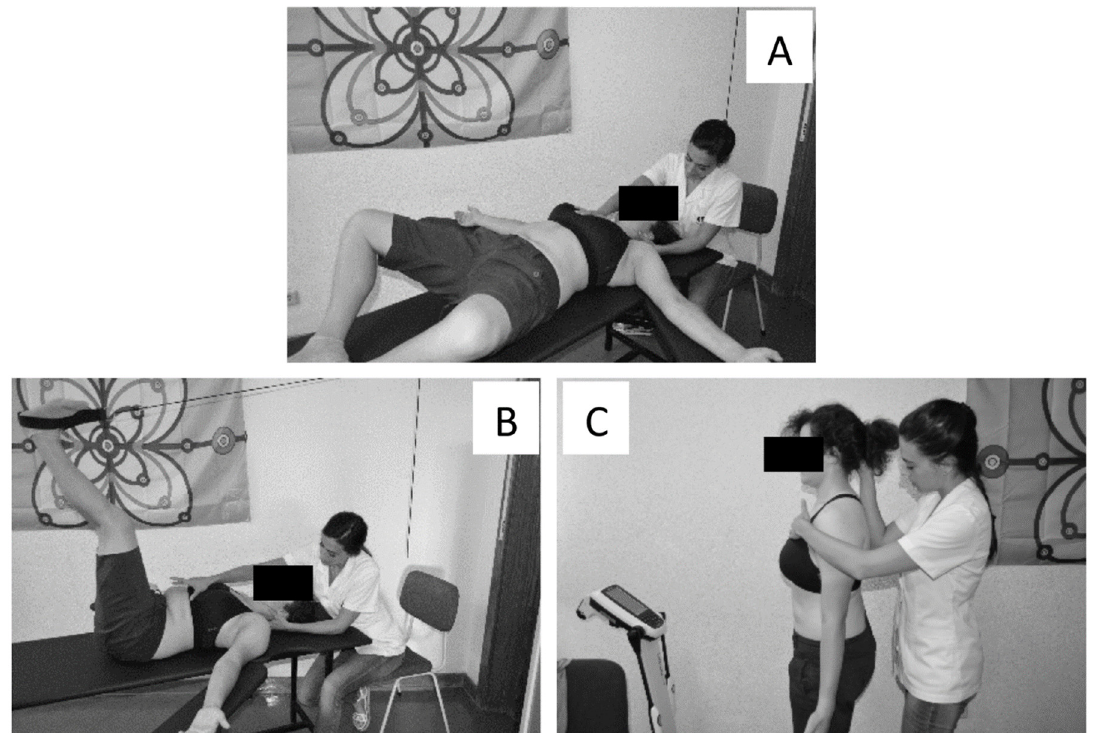
Figure 2. The 3 positions of the Global Postural Reeducation intervention. ( A ) Lying posture to stretches the anterior muscle chain; ( B ) lying posture to stretches the posterior muscle chain; ( C ) standing posture.